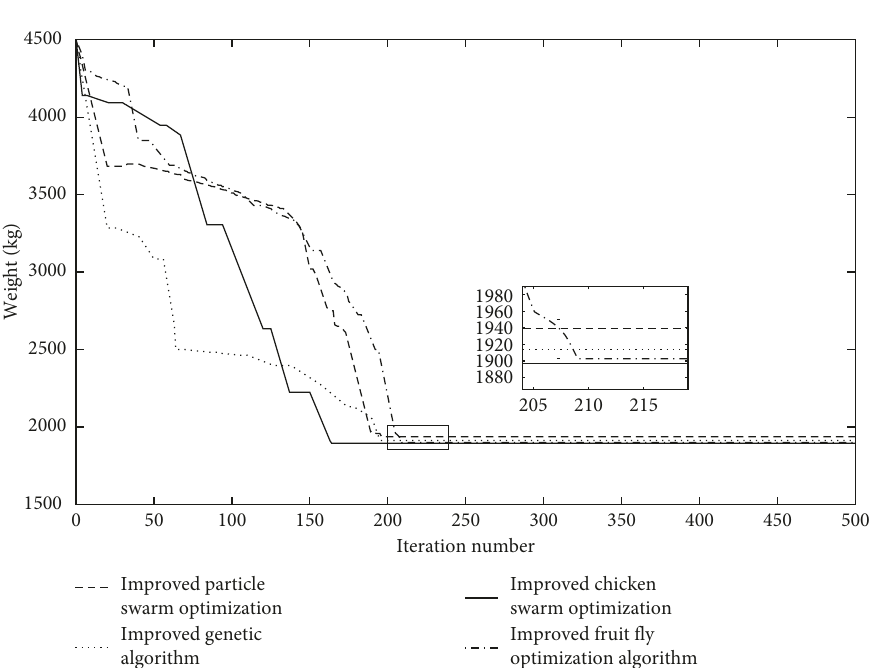
Figure 10: Four algorithms for finding the iterative curve of